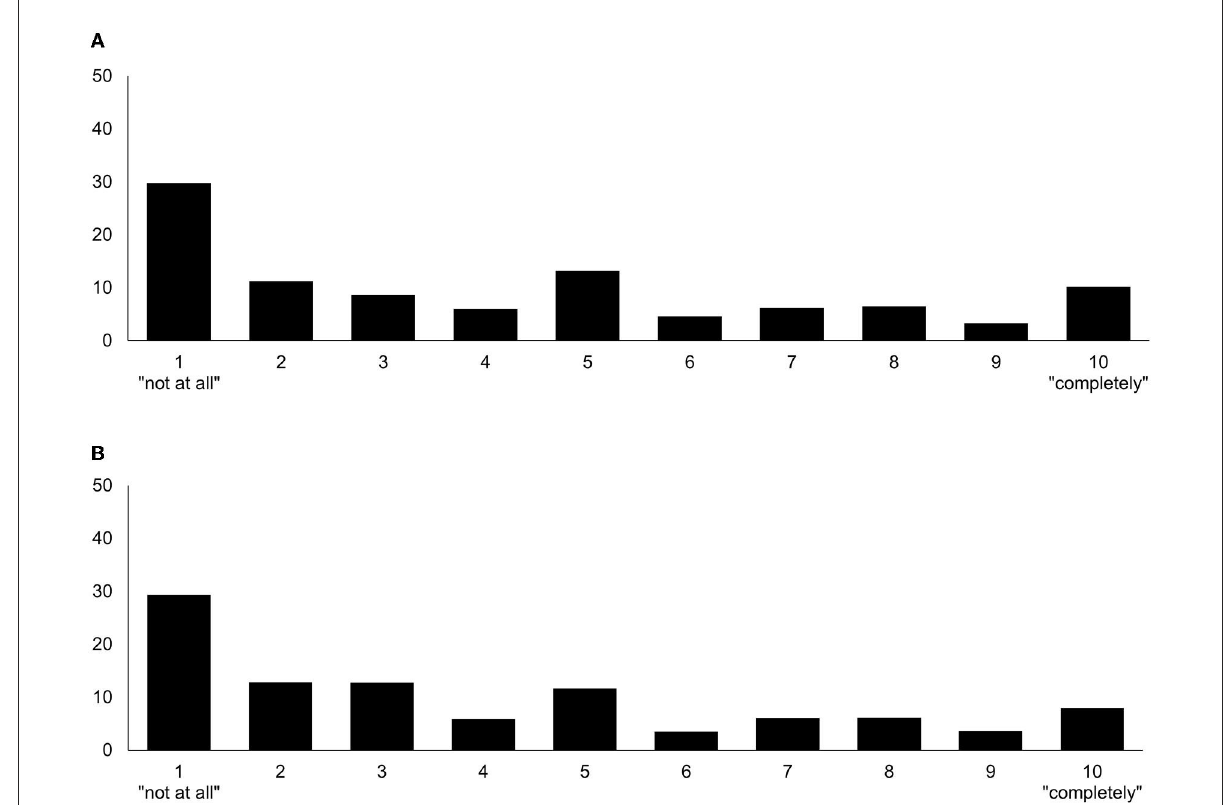
FIGURE2 Distribution of answers (in %) of the moral judgment (A) and willingness (B) ( N = 1,349).